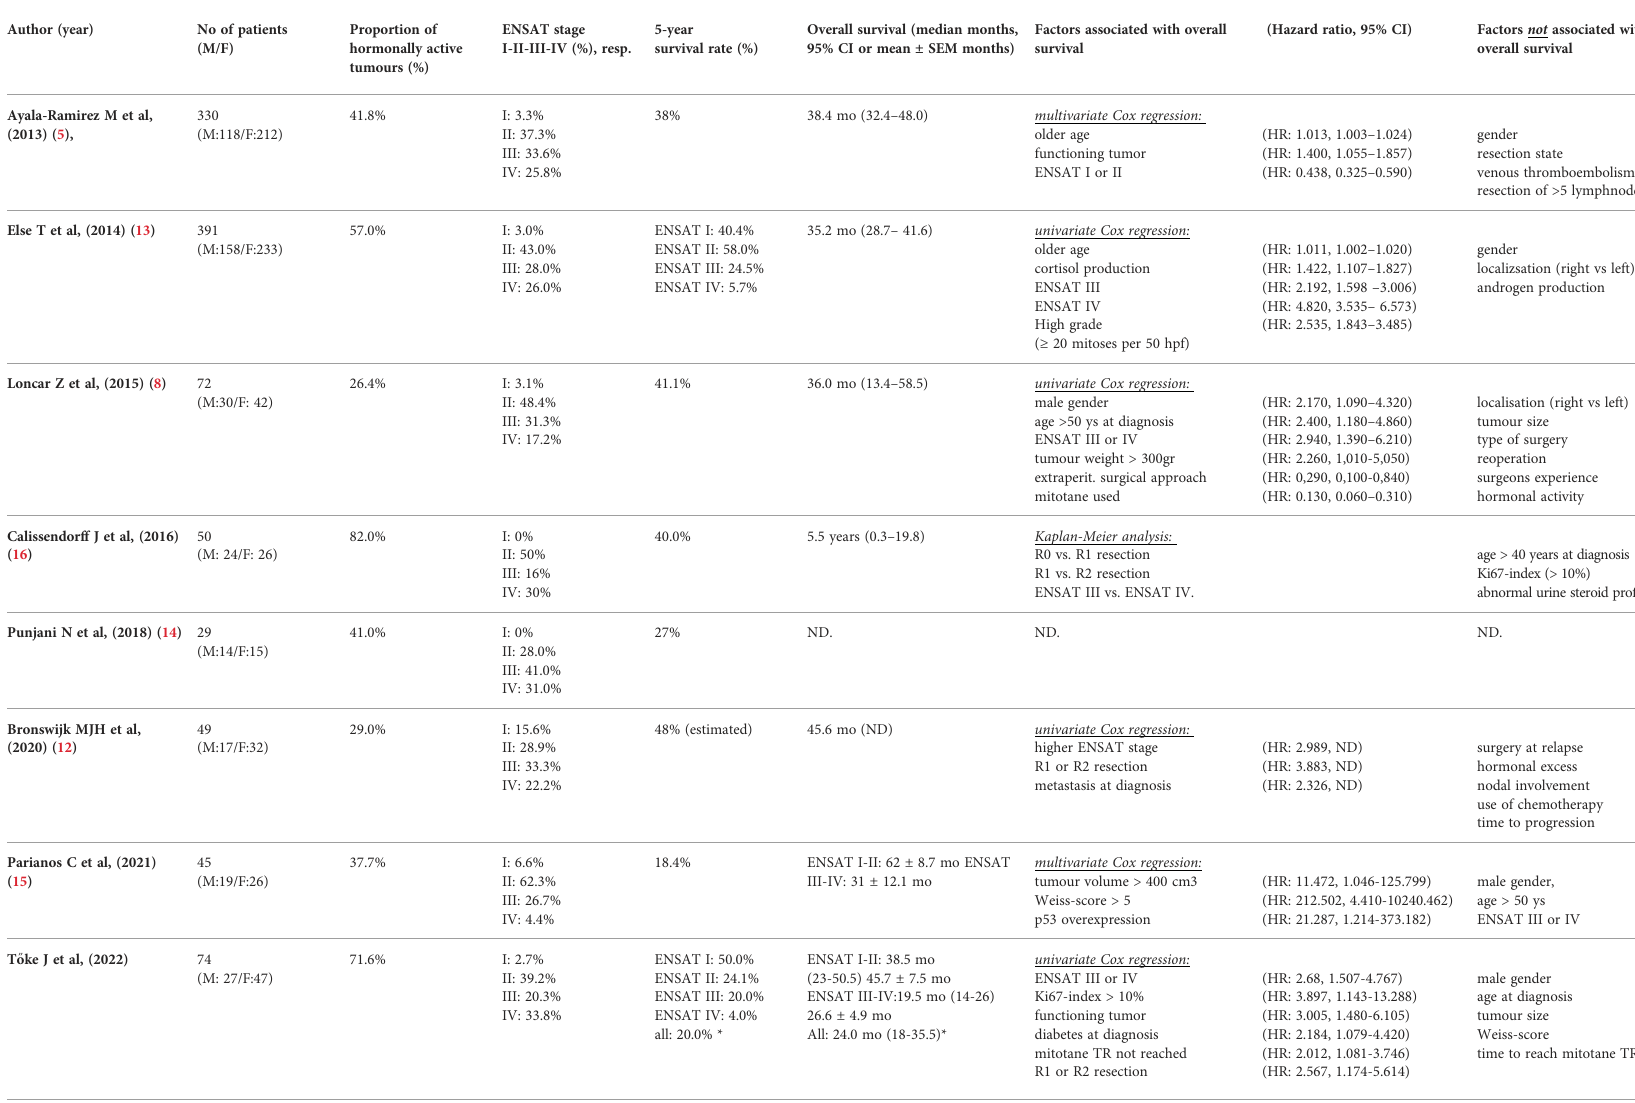
*:Patients whose survival was less than 4 months from the diagnosis without any speci fi c treatment (n = 4) have been excluded from the analyses. M, male; F, female; ENSAT, European Network for the Study of Adrenal Tumors; mo, months; ys, years; TR, therapeutic range; EDP, Etoposide-Doxorubicin-Cisplatin; ND, no